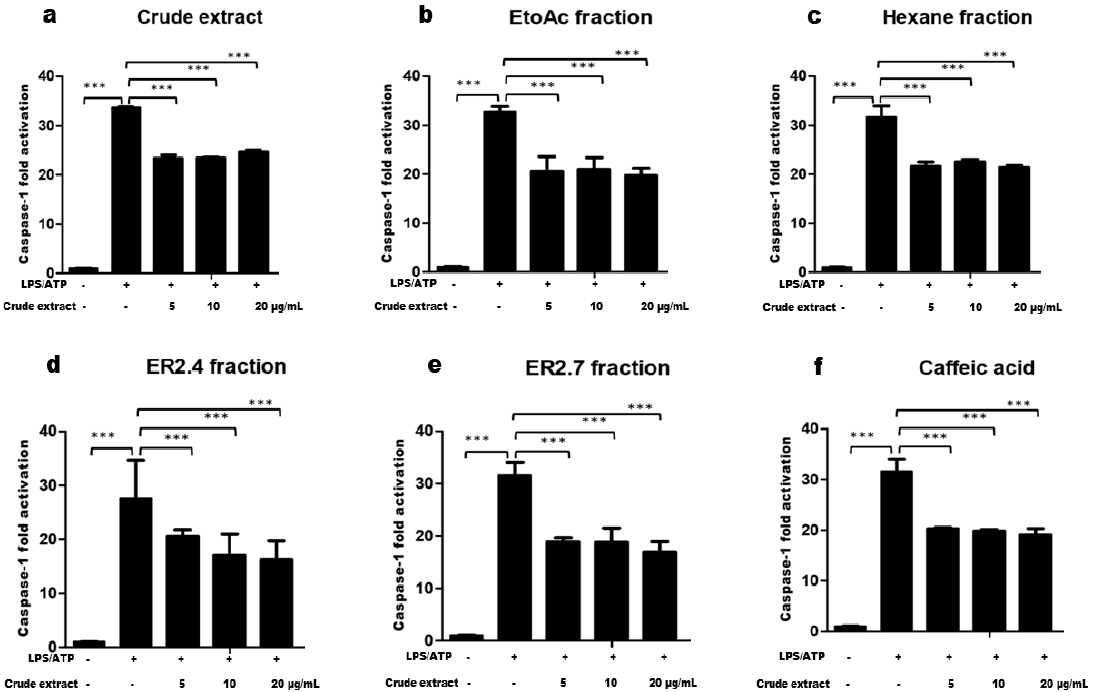
Figure 2. Crude extract ( a ) and Hexane ( c ) and ethylacetate ( b ) fractions as well as the ca ff eic acid ( f ) and semi-purified fractions, ER 2.4 ( d ) and ER 2.7 ( e ), thereof exhibited significant inhibition of caspase-1 in THP-1 derived macrophages. Phorbol Myristate Acetate (PMA)-di ff erentiated cells were pretreated by corresponding compounds for 1 h, and then primed by Lipopolysaccharide (LPS) (1 µ g / mL) for 3 h. Cells were then stimulated by ATP (5 mM) for additional 1 h. The supernatants were harvested and kept at − 70 ◦ C before analysis. Then, 50 µ L of the culture supernatant were used to determine the caspase-1 activity using Caspase-Glo 1 inflammasome assay (Promega Co., Madison, WI, USA). The results are presented as the mean ± SD from independent experiments ( n = 2), each done in triplicate. A one-way ANOVA, followed by Benforroni’s multiple comparison test, was used to compare the sample groups. *** means Caspase-1 fold activation changes with a p < 0.0001.